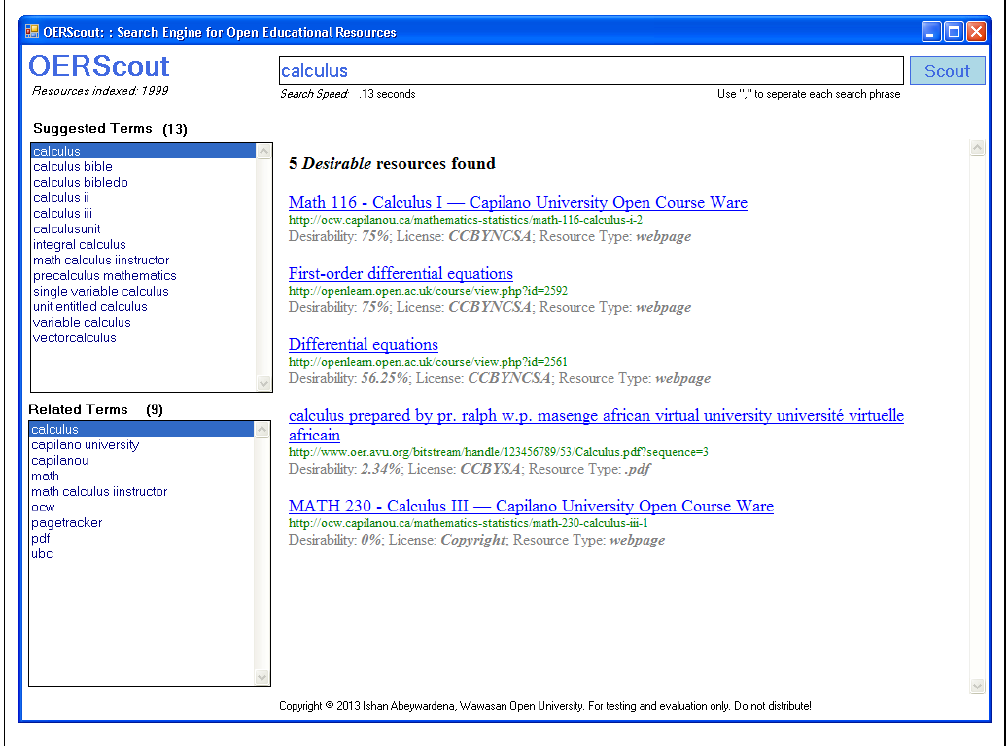
Figure 7 . Search results generated by OERScout for the term “calculus”. The desirable resources returned are from Capilano University, The Open University, and African Virtual